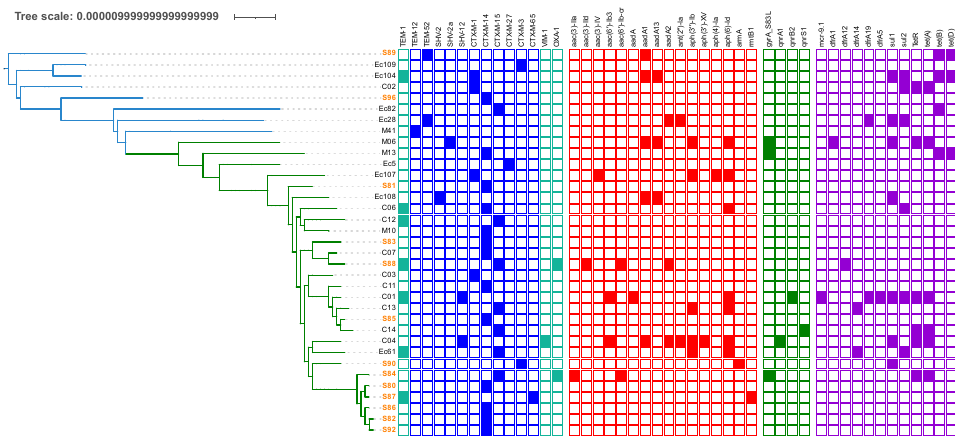
Figure 3. AMR genes distribution among Escherichia coli ST141 genomes with ESBL gene. Sublineages were indicated by edge coloring (S1, green edges, S2, blue edges). The presence/Absence of genes encoding AMR were indicated by colored squares (blue: β -lactam resistance—ESBL were shown in dark blue; red: aminoglycosides resistance; green: quinolone resistance; purple: